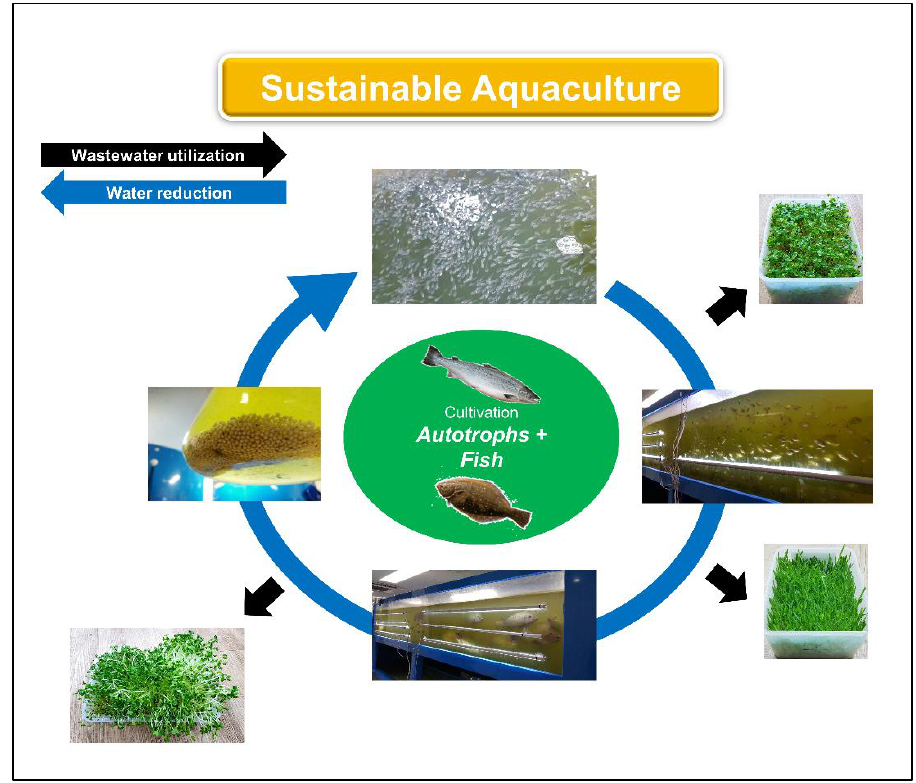
Figure 5. The autotrophic biofloc technology (ABFT) as sustainable aquaculture